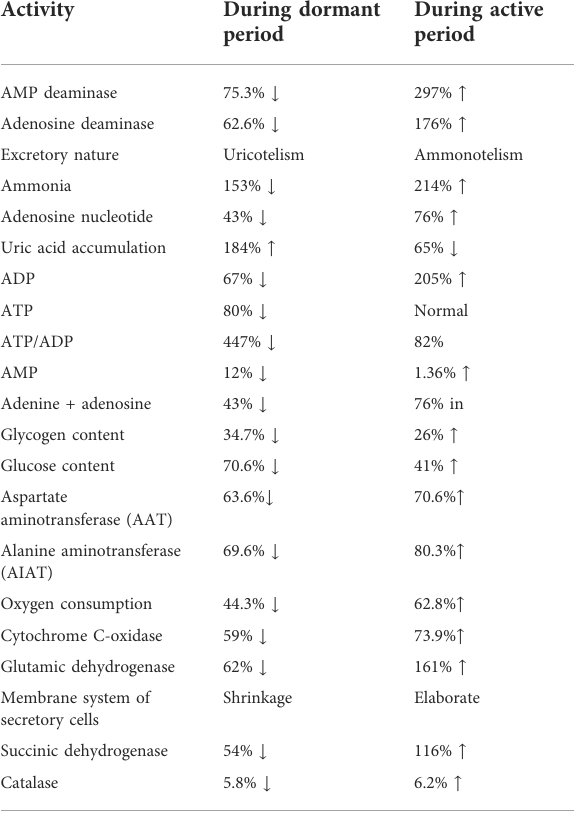
TABLE 2 Environmental induced alteration of different physiological activities of Pila globosa during dormant and active periods.